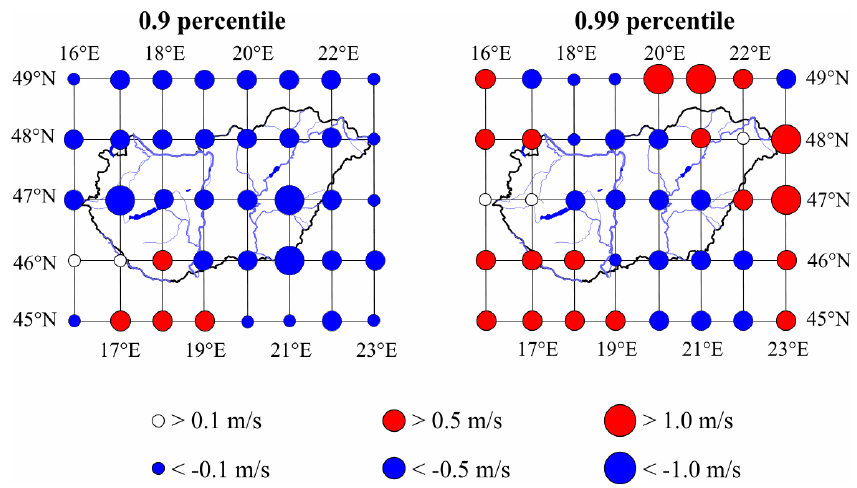
Figure 4. Spatial distribution of linear trend fitted on di ff erent percentile values (0.9 – left, 0.99 – right) calculated from three-year Figure 4.